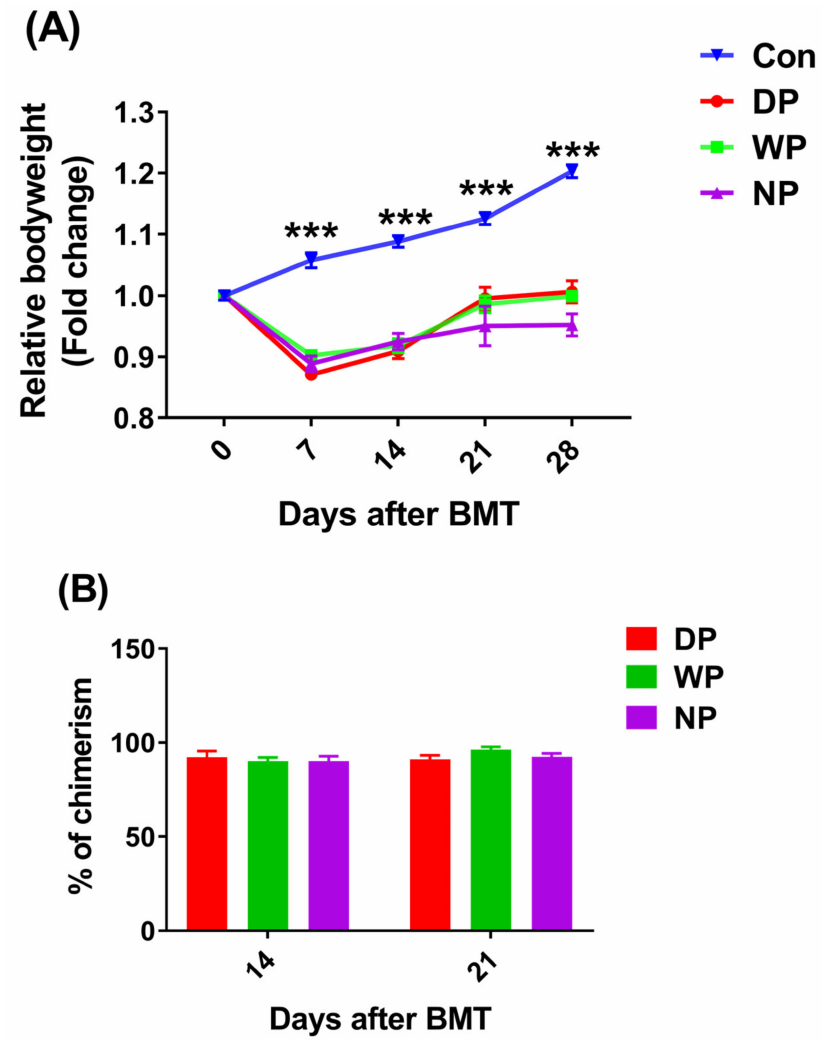
Figure 1. Relative body weight and donor chimerism as a function of time after BMT. BALB/c mice post-BMT were supplemented with DP, WP, or NP. The weights of the mice were obtained at different time points, and relative body weight was calculated ( n = 23–30) ( A ). Donor chimerism was measured using anti-mouse H-2Kd (FITC) and H-2Kb (PE) on days 14 and 21 ( n = 6) ( B ). Data are presented as mean ± SEM. Results were obtained from at least two independent experiments. *** p <